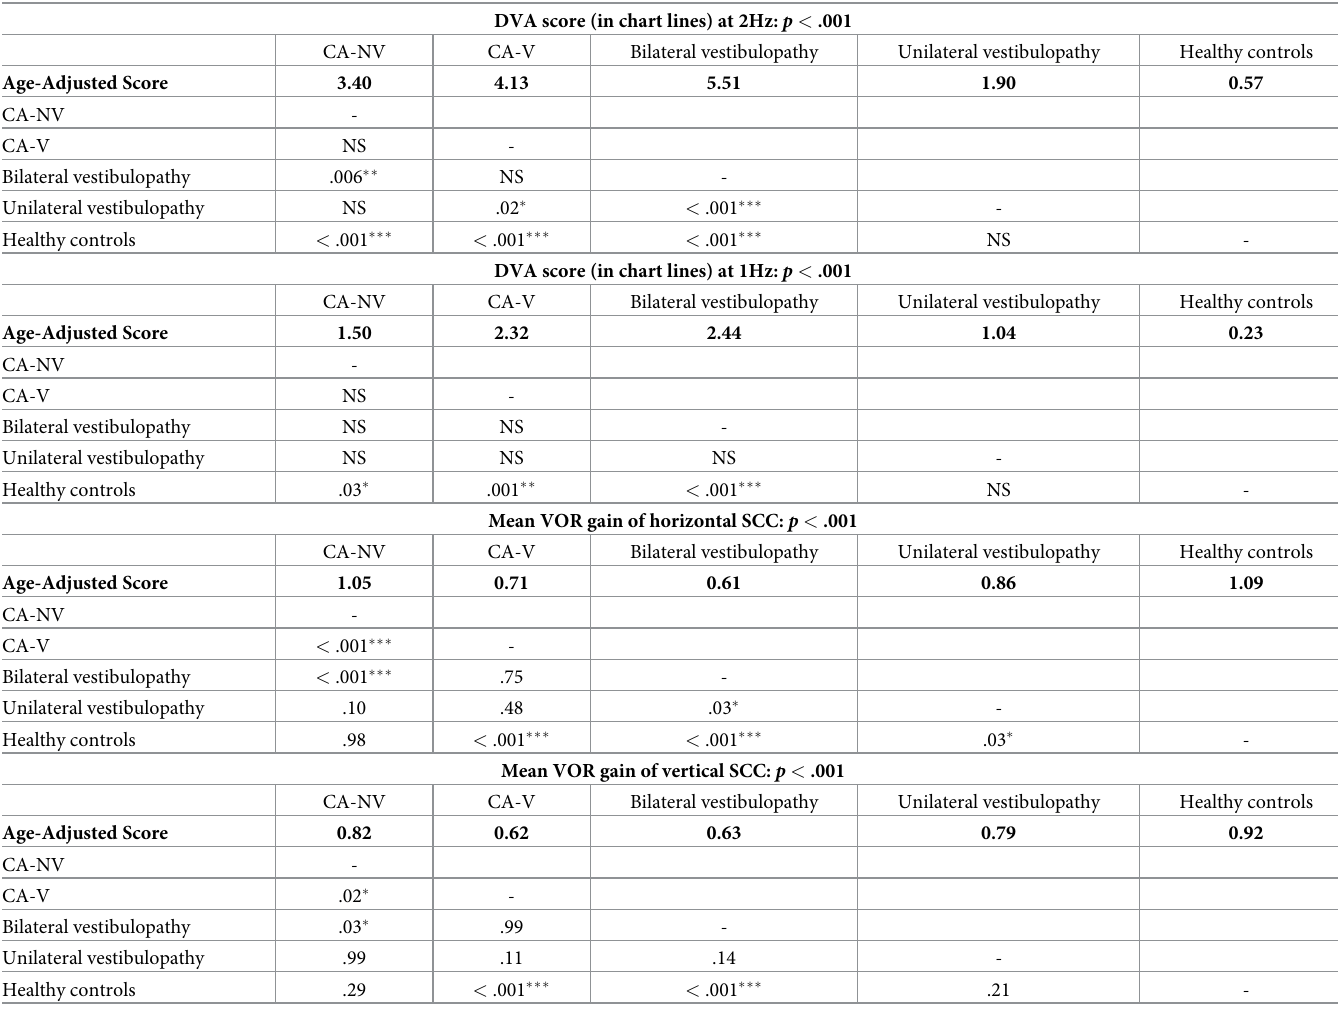
Table 2. Comparison between groups.